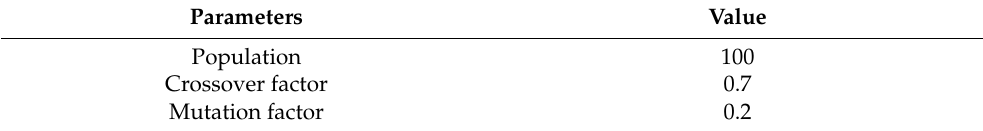
Table 2. Genetic algorithm settings for